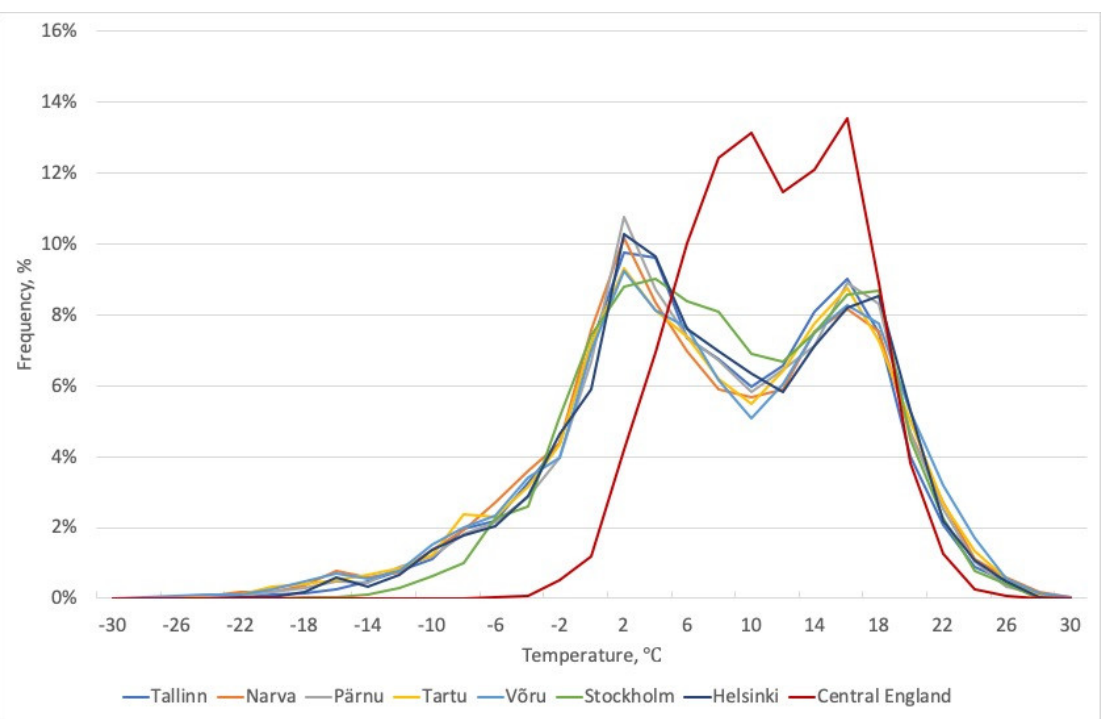
Figure 3. Frequency distributions of average daily air temperatures during the period 2005–2019. Percentages are calculated for 2 °C intervals.